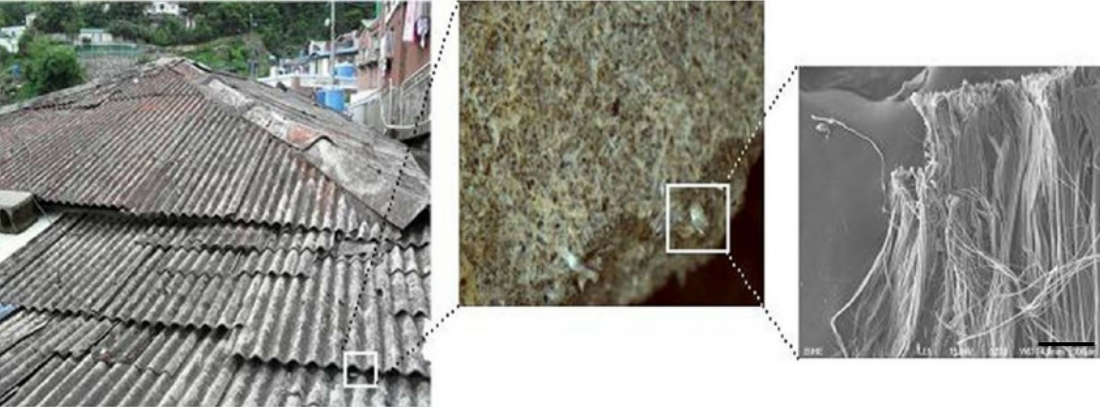
Figure 1. Asbestos-cement slate roofs ( left ) and Scanning Electron Microscope (SEM) image ( right ) of chrysotile in the slate roofs. The bar size in the right image indicates 100 µm.